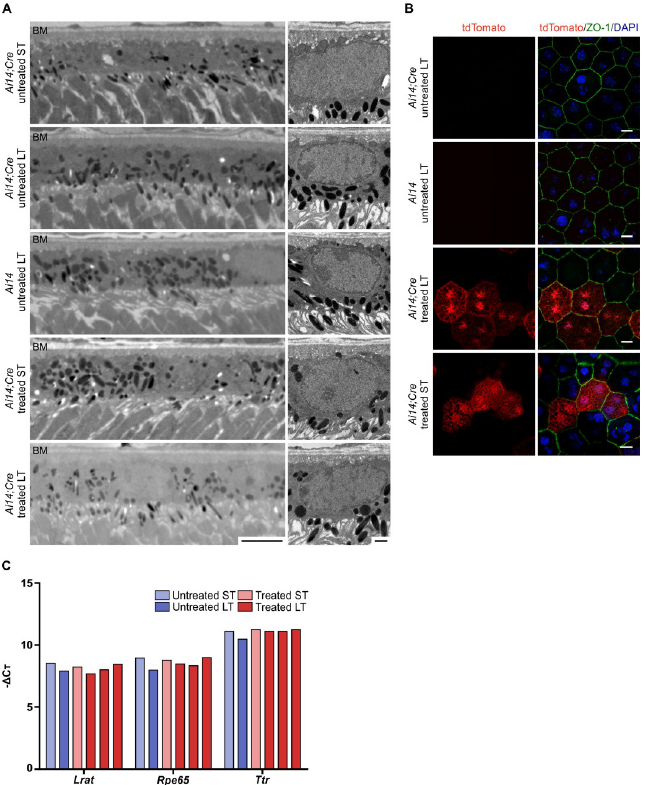
Fig 7. Analysis of the long-term effect of Cre activity on RPE cells of adult Ai14;RPE-Tyrosinase-CreEr T2 mice. A: Electron micrographs of adult RPE at lower (left) and higher magnification (right), showing no phonotypical abnormalities after short- and long-term Cre activity. B: Flatmount preparations of adult RPE after short-term and long-term Cre activity, showing no morphological changes in cells expressing tdTomato expression (red) and no expression in untreated mice. The tight junction-associated protein ZO-1 (green) was labeled to visualize the cell borders. C: qRT-PCR shows no difference in expression of mature RPE markers ( Lrat , Rpe65 and Ttr ) relative to housekeeping gene ( Tbp ). Ai14;Cre : Ai14;RPE-Tyrosinase-CreEr T2 . ST: short-term effect of tamoxifen-treatment. LT: long-term effect of tamoxifen-treatment. BM: Bruch’s membrane. Scale bars: (A) right: 5 μ m, left: 1 μ m, (B) 10 μ